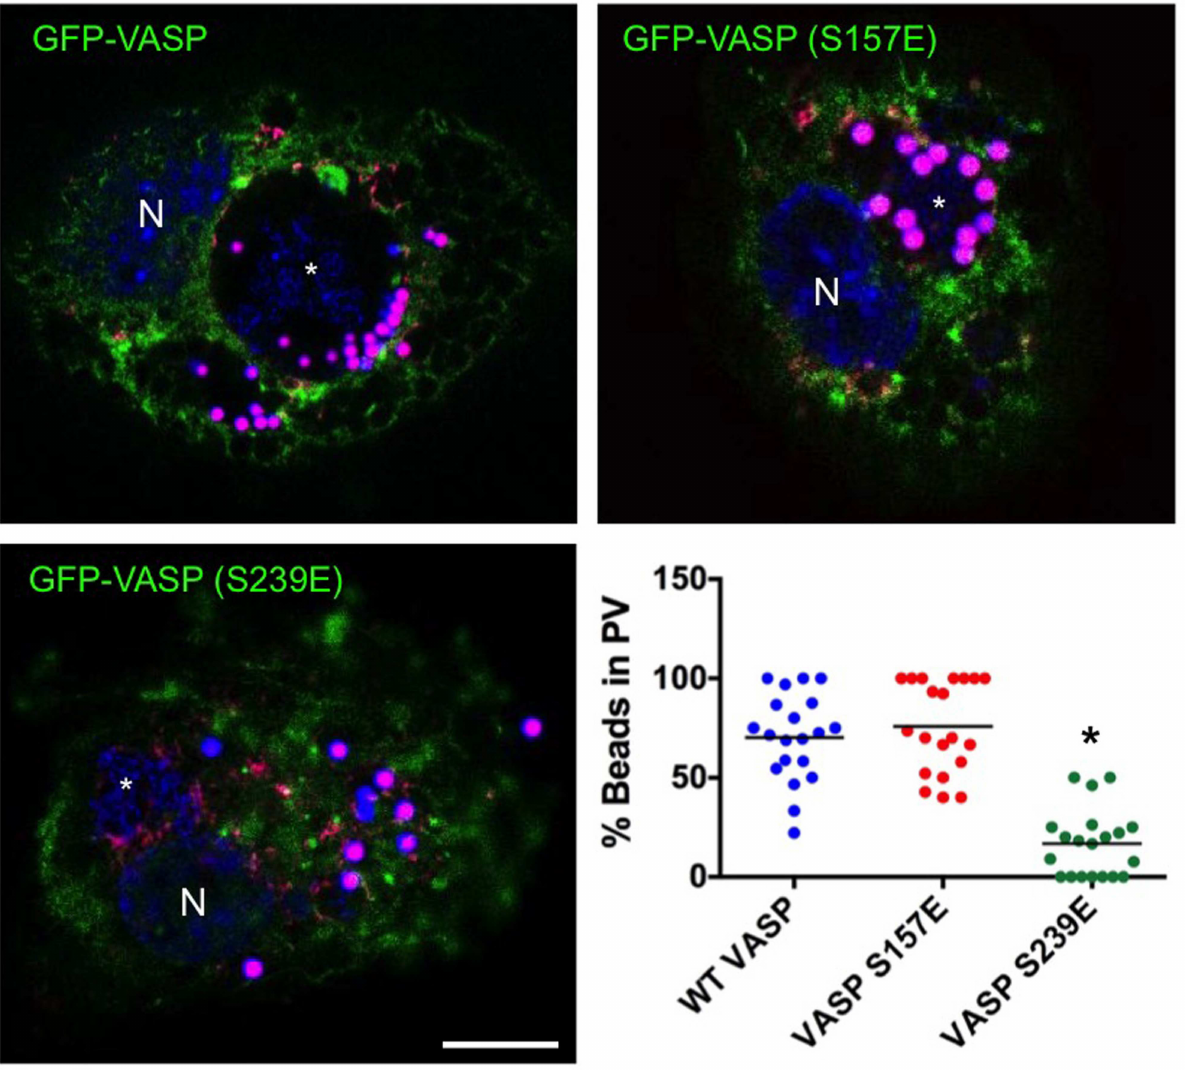
Fig 8. VASP (S239E) expression prevents phagosome trafficking to the PV. THP-1 cells were transfected with wild type (WT) GFP-VASP (GFP-VASP), GFP-VASP (S157E), or GFP-VASP (S239E), then infected with C . burnetii . Cells were incubatedwith fluorescent beads (violet) overnight and processed for confocal microscopy at 72 hpi. DNA was stained with DAPI (blue). Bar, 10 μ m. N = nucleus and * indicates the PV in micrographs. The scatter plot displaysthe percentageof beads present within PV in GFP-VASP-, GFP-VASP (S157E)-, or GFP-VASP (S239E)-expressing cells. At least 20 cells from randomly selected fields were used for quantification. The horizontalbar indicates average percentage. * indicatesp < 0.0001 accordingto a Student’s t test comparingwild type- and mutant VASP-expressing cells. Bead-containing phagosomes were directed to the PV in GFP-VASP- and GFP-VASP (S157E)-expressing cells. However, GFP-VASP (S239E) expression impaired bead trafficking to the PV.